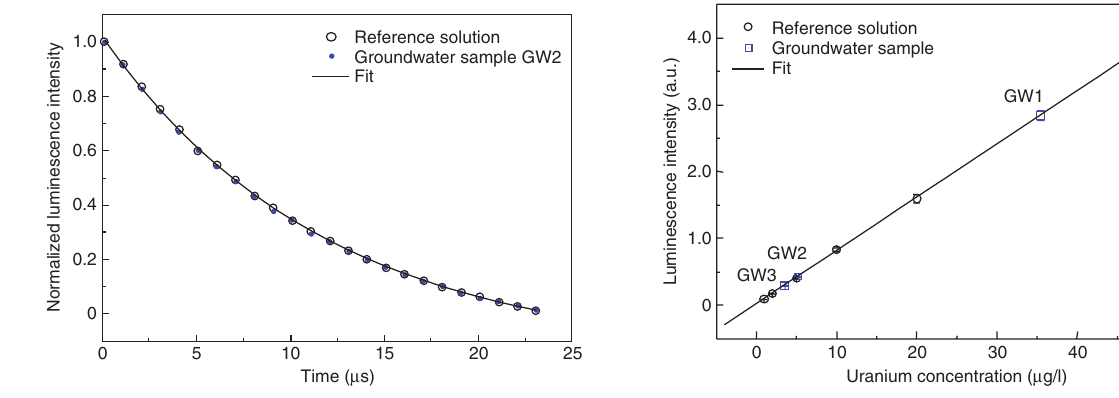
Figure 5 Open and solid circles represent the normalized lumines- cence signal waveforms measured from the same samples shown in Figure 4. The solid line is the result of fitting the data to a first-order expo- nential decay function with a luminescence lifetime of 11.9 ± 0.4 μ s.